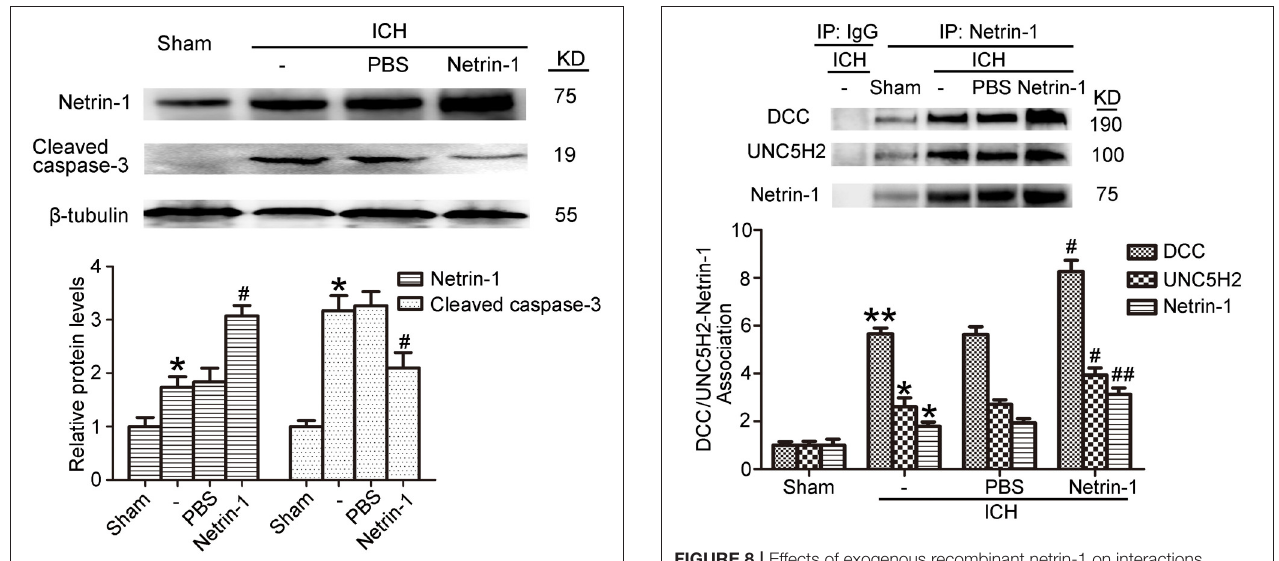
FIGURE 6 | Effects of exogenous recombinant netrin-1 on ICH-induced SBI. Western blot of protein levels of netrin-1 and cleaved caspase-3 in the peri-hematoma cortex at 48h after ICH onset. Mean values of protein levels in the sham group were normalized to 1.0. All values are expressed as mean ± SEM. * p < 0.05 vs. the sham group. # p < 0.05 vs. the ICH + PBS group, n = 6.